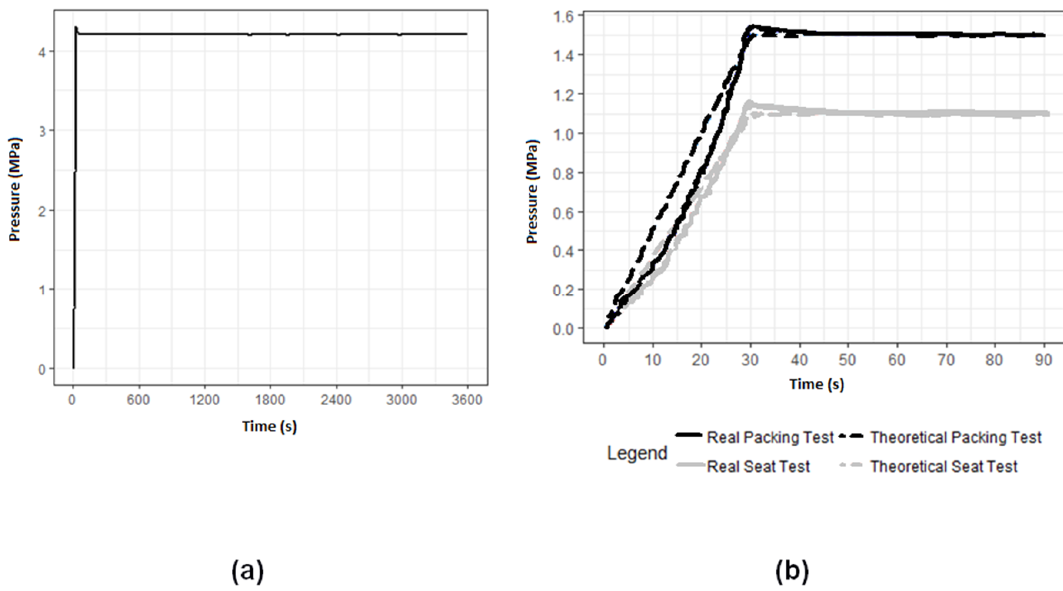
Figure 5. ( a ) Shell test results; ( b ) Seat packing test results.